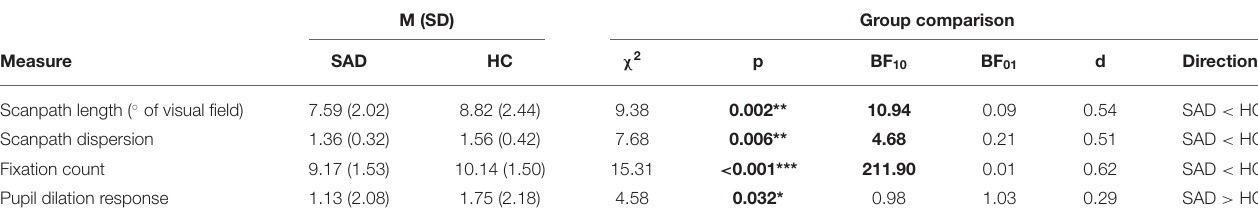
TABLE 3 | Group differences between youth with SAD and healthy controls in scanpath length, scanpath dispersion and pupil dilation response. M (SD) Group comparison